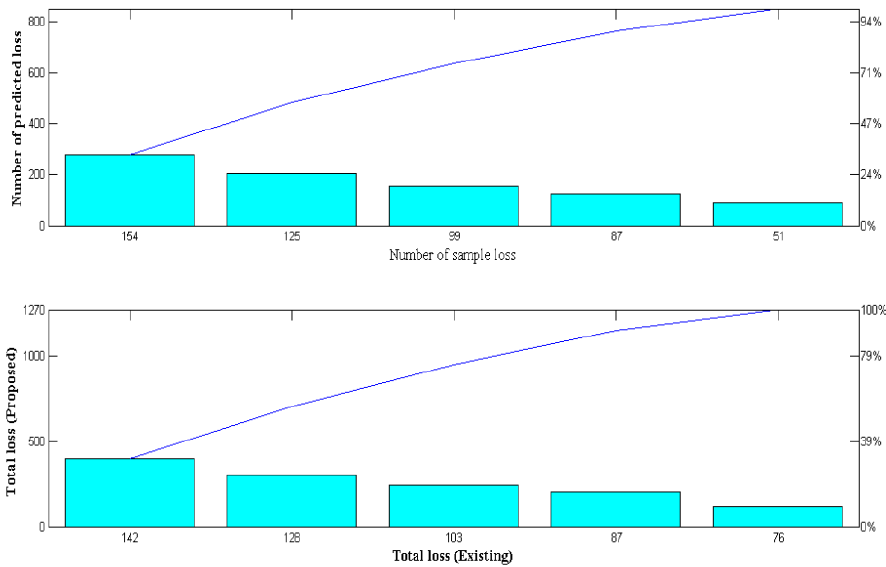
Figure 7. Comparison of loss factor.